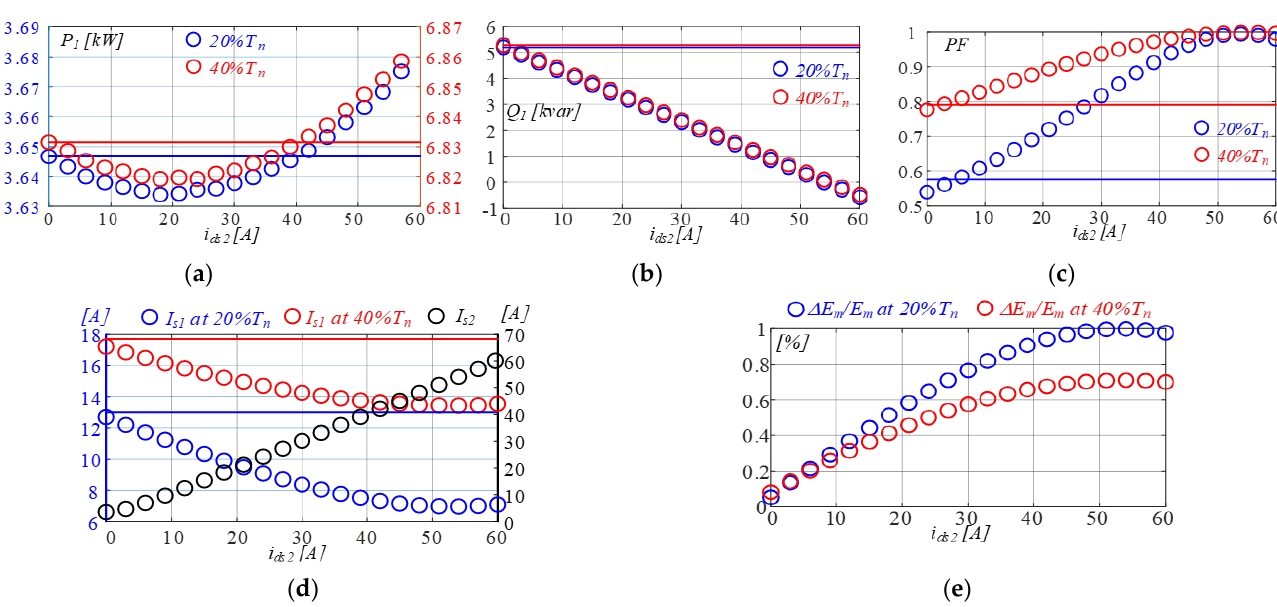
Figure 8. ( a ) Active and reactive power ( P 1 and Q 1 , respectively), ( b ) power factor PF, ( c ) main winding current magnitude I s 1 , ( d ) auxiliary winding current magnitude I s 2 , ( e ) p.u. back-electromotive force (EMF) variation ∆ E m , computed at 20% and 40% of rated torque T n for different values of i ds2 (solid lines — standard IM; circles — DWIM).